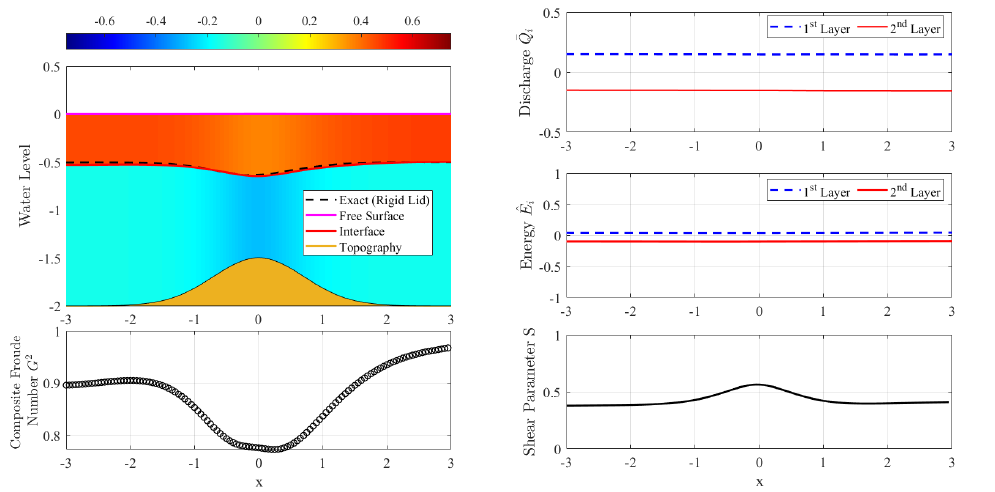
Figure 5. ( Left ) Steady interface in the case of subcritical flow. The fluid velocity for each layer is represented by the color scale. ( Right ) Plots of discharge and energy for each layer, as well as the shear